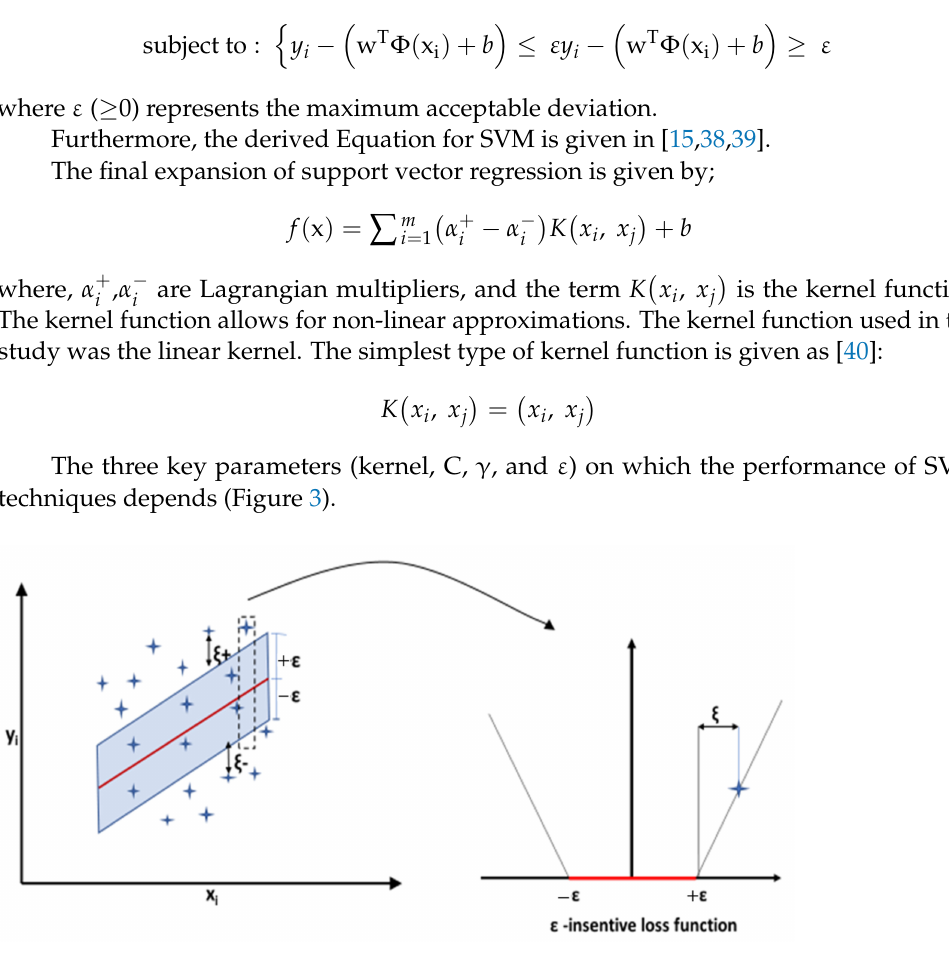
Figure 3. Soft margin loss setting for a linear SVM and ε -insentive loss function adapted after Lin et al.